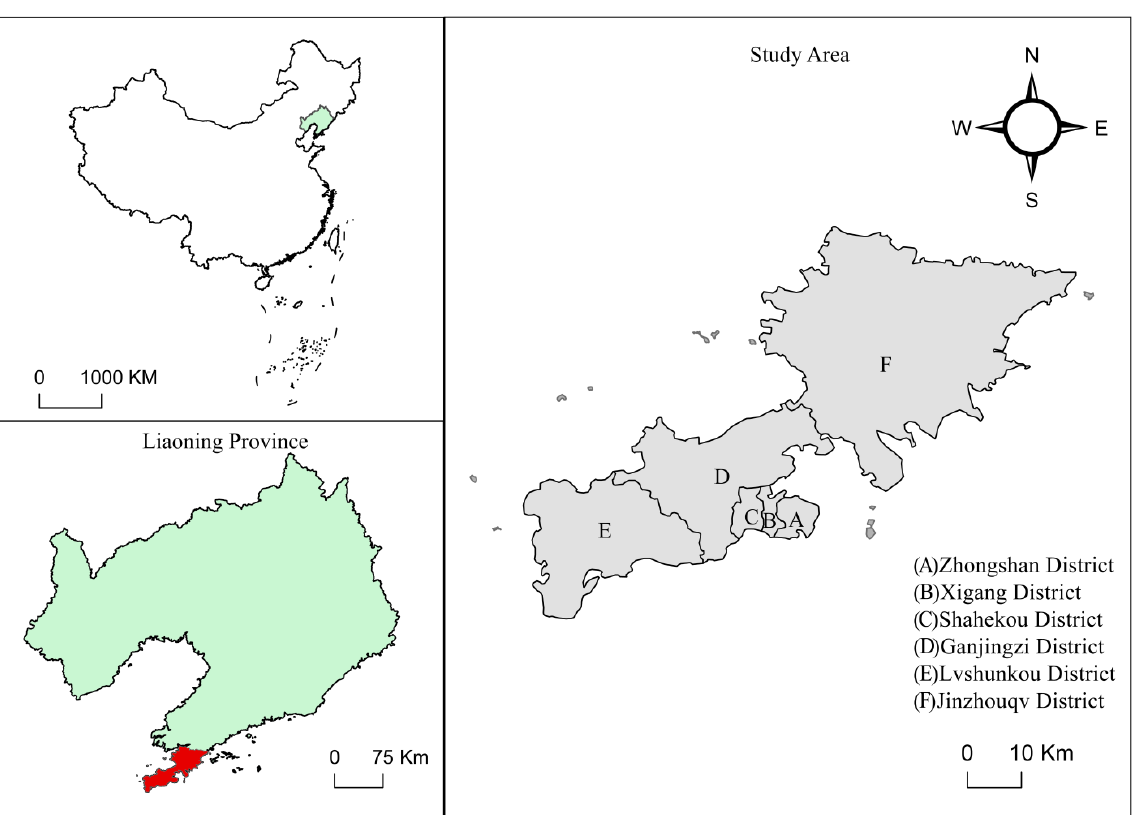
Figure 1. Overview of the study area.